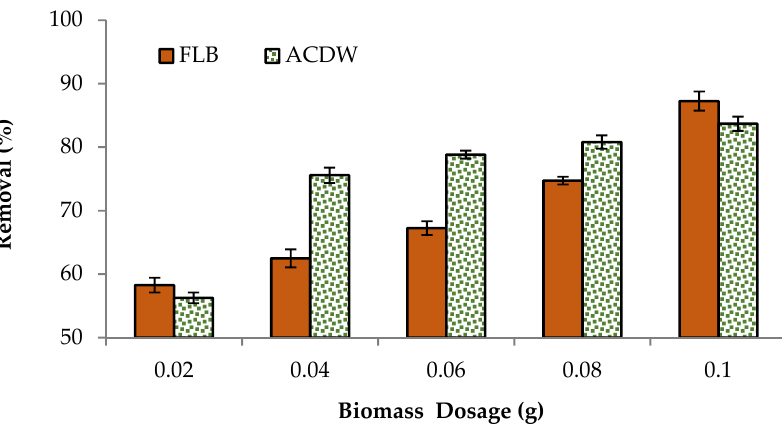
Figure 4. Influence of adsorbent dosage on the elimination efficiency of IV2R dye.